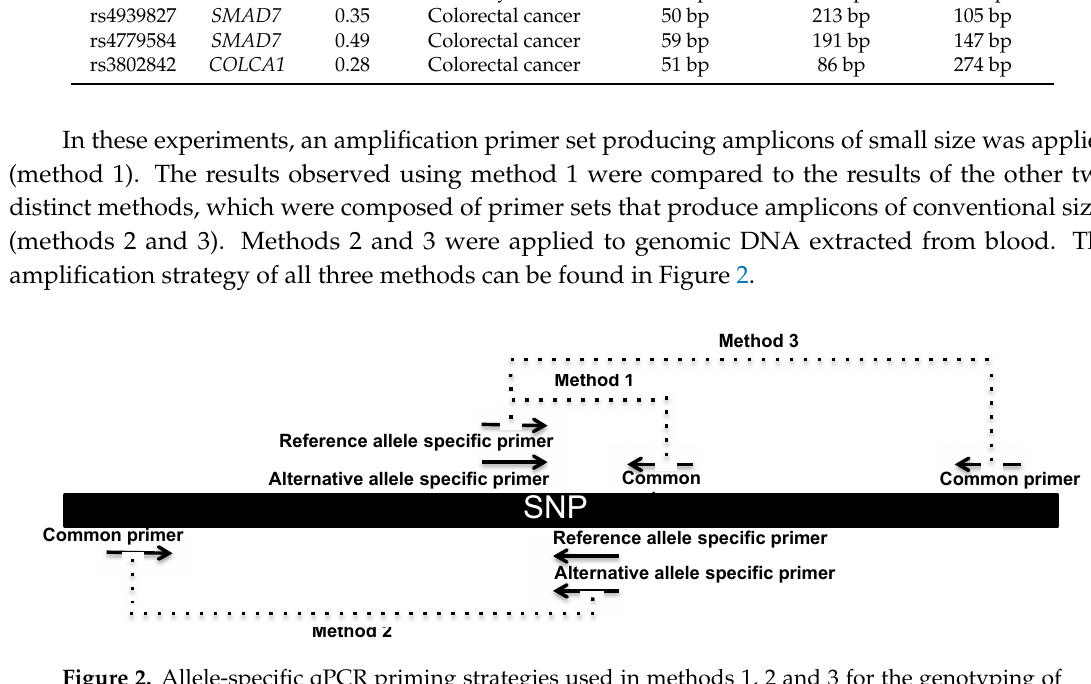
Figure 2. Allele-specific qPCR priming strategies used in methods 1, 2 and 3 for the genotyping of rs1801131, rs4939827, rs4779584 and rs3802842. Note: primer details can be found in Table 2.